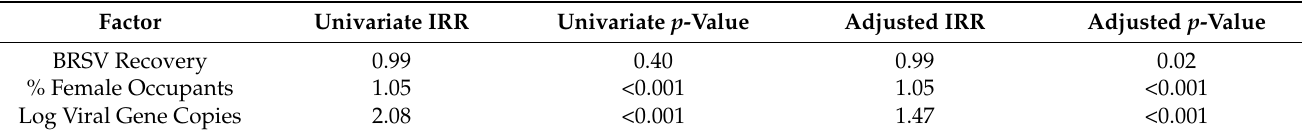
Figure 5. Total daily isolation building occupancy (line) plotted with N1 and N2 gene copies/day (bars) during the Spring 2021 academic semester. Note: Both SARS-CoV-2 daily wastewater viral loads and daily isolation residence occupancy totals are reported on linear y-axes (n = 64). Table 2. Time series negative binomial models to quantify associations between captured viral loads and defined patient populations, Massachusetts 2021. Note: IRR = Incidence Rate Ratio.